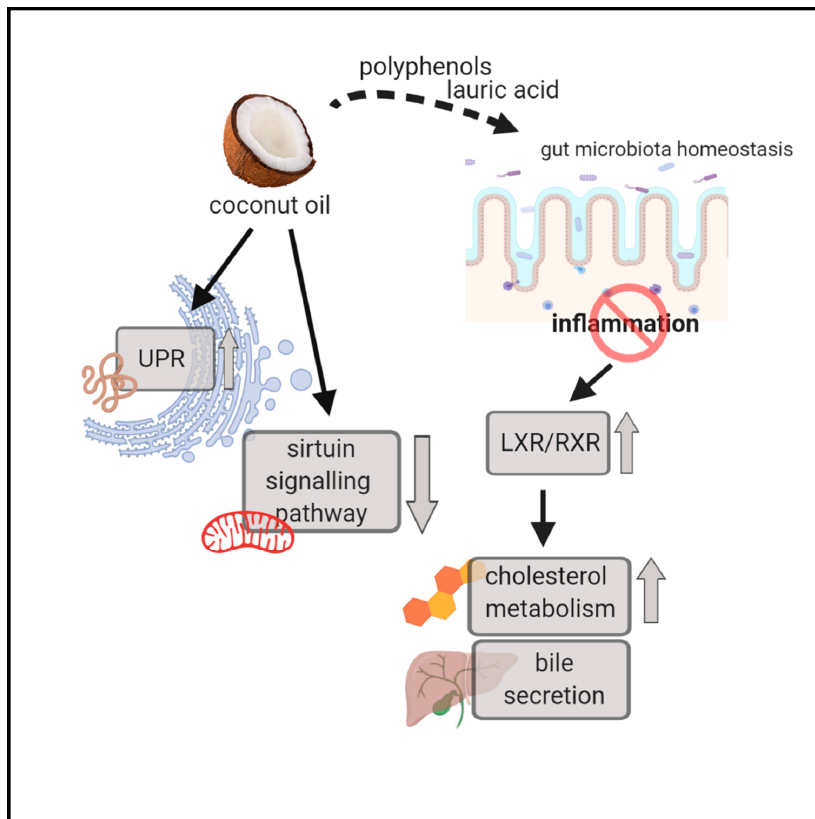
Figure 9. Graphical illustration of selected biological processes and canonical pathways altered in the coconut oil group when compared to the rapeseed oil (UPR, sirtuin signaling pathway) and beef tallow groups (LXR/RXR activation, cholesterol metabolism, bile secretion). Coconut oil contains antibacterial and anti-inflammatory ingredients (lauric acids, polyphenols), and cholesterol metabolism and bile acid secretion are not reduced as a result of increased inflammation, which is observed in the beef tallow group.